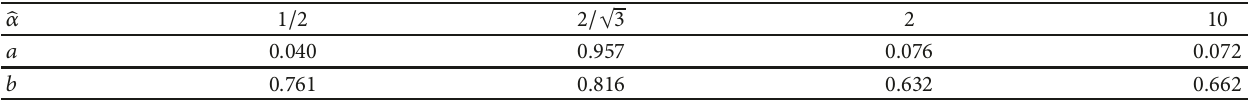
off-axis new branch cuts for ̂𝛼 = 0 to the purely imaginary